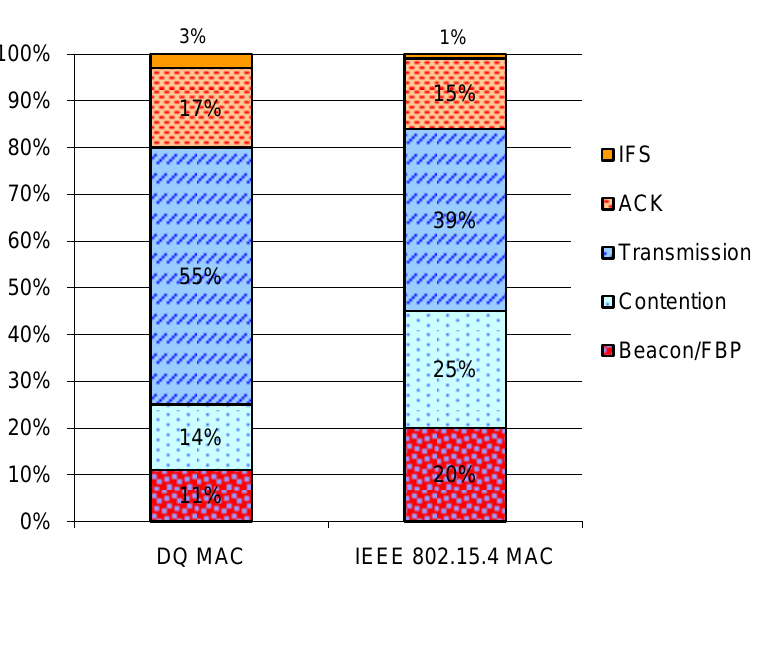
Figure 10. Breakdown of energy